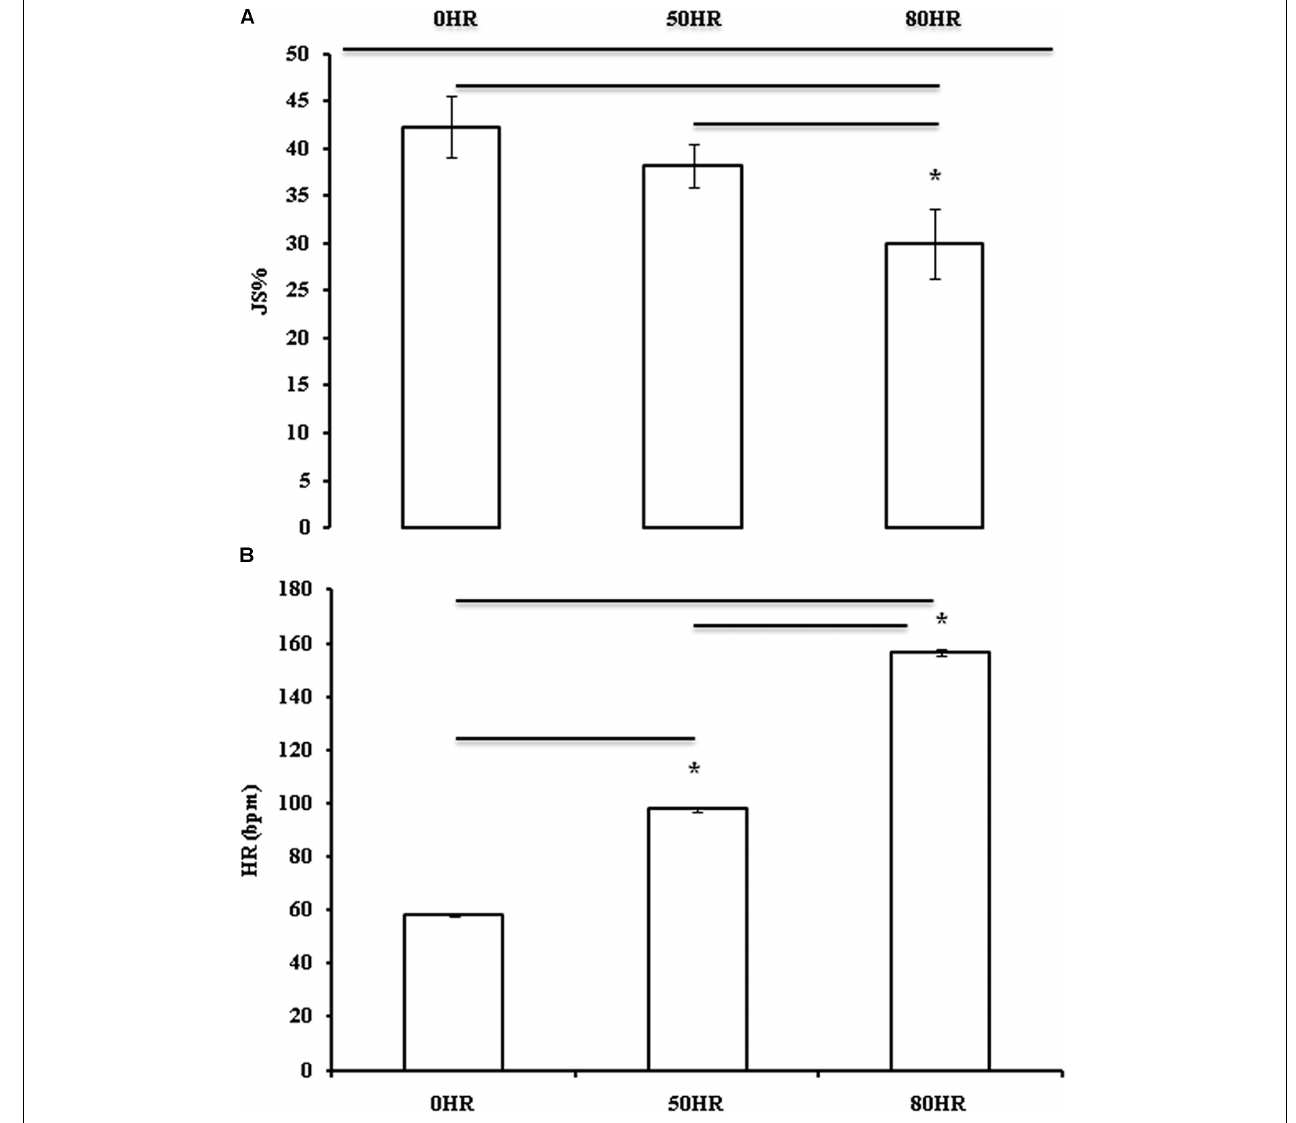
FIGURE 2 | Percentage of jump-shot success (JS%), top (A) and heart rate [HR (bpm)], bottom (B) , as Mean ± SD, over the three different testing conditions (at rest, 50% maximal heart rate, and 80% maximal heart rate as 0HR, 50HR, and 80HR; n = 22). ∗ P <